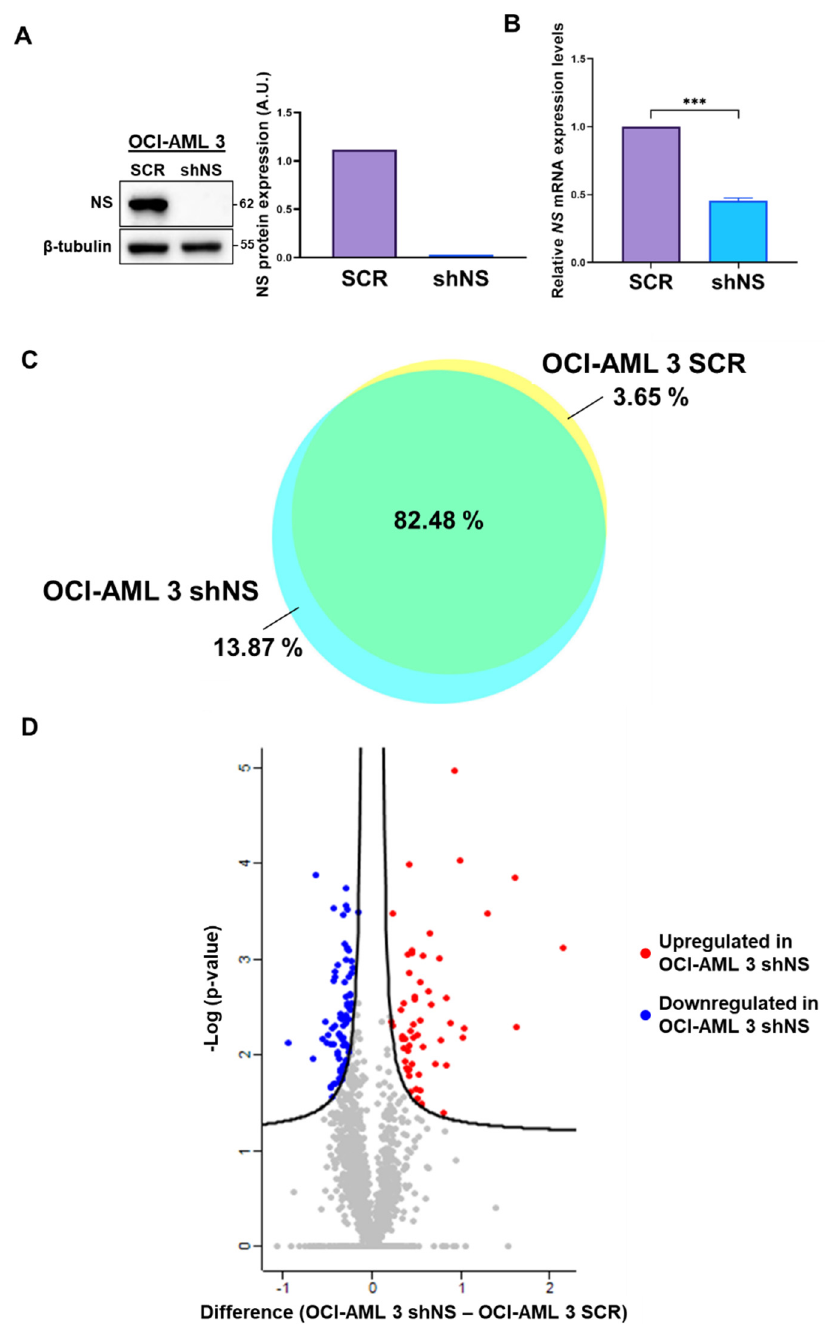
Figure 1. NS expression, silencing and differential proteomics analysis of OCI-AML 3 cells. ( A ) Western blot (WB) images of NS protein levels in OCI-AML 3 cells in SCR (not silenced) and shNS (silenced for NS) after 72 h of doxycycline induction. Twenty-five micrograms of total lysates were loaded for each sample. Histogram represents intensity levels of protein bands of Western blot image normalized for β -tubulin protein expression. ( B ) NS mRNA expression levels in control (SCR) and silenced (shNS) OCI-AML 3 cells after 72 h of doxycycline treatment. mRNA levels were evaluated by qRT-PCR and normalized to B2M expression levels. Asterisks represent significant differences with respect to SCR control. *** p < 0.001, Student’s t -test. ( C ) The Venn diagram highlights the commonly expressed proteins between NS-silenced (shNS) or not (SCR) OCI-AML 3 cells. ( D ) Volcano plot of common proteins graphed by difference parameter and –Log( p -value). Blue dots represent proteins that were significantly down-regulated in OCI-AML 3 shNS, while red dots indicate proteins that were significantly up-regulated in OCI-AML 3 shNS compared to the control OCI-AML 3 SCR. Grey dots represent proteins that were not differentially expressed in the comparison carried